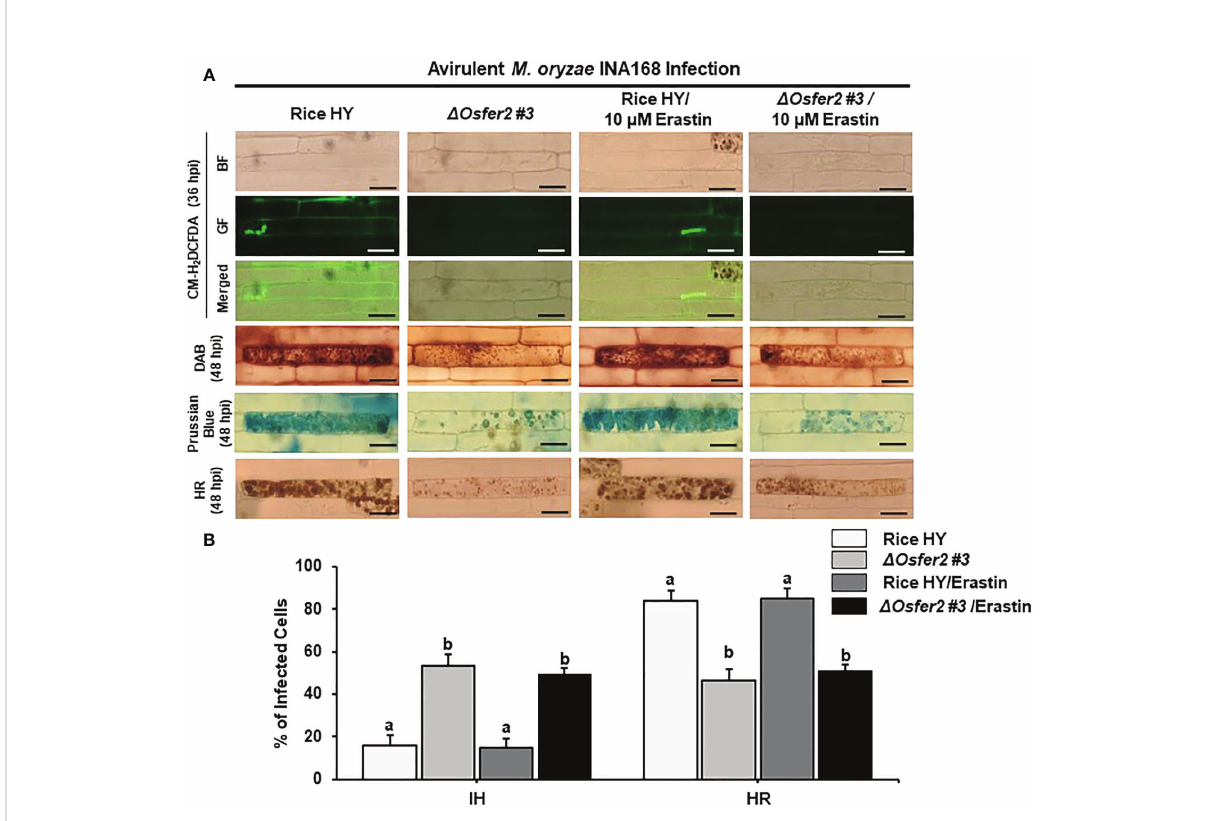
FIGURE 13 Treatment with erastin does not induce iron- and ROS-dependent ferroptotic cell death in rice sheath epidermal layers of D Osfer2 knock-out mutants during avirulent Magnaporthe oryzae INA168 infection. (A) Images of HR cell death, DAB, Prussian blue and CM-H 2 DCFDA staining of rice sheath epidermal cells infected with M. oryzae INA168 and treated with erastin (10 µM). Scale bar=20 µm. (B) Quanti fi cation of invasive hyphae IH and hypersensitive response (HR) cell death in rice sheath cells infected with M. oryzae INA168 and treated with erastin. M. oryzae conidia (4×10 5 conidia mL − 1 ) were mixed with 10 mM erastin and then inoculated on leaf sheaths, followed by 48 h-incubaion at 25°C in dark condition. The values are means ± SD; n=4 leaf sheaths from different plants. Different letters above the bars indicate signi fi cantly different means ( P <0.05), as analyzed by one-way ANOVA analysis. hpi, hour post-inoculation; HR, hypersensitive response; BF, bright fi eld; GF, green fl